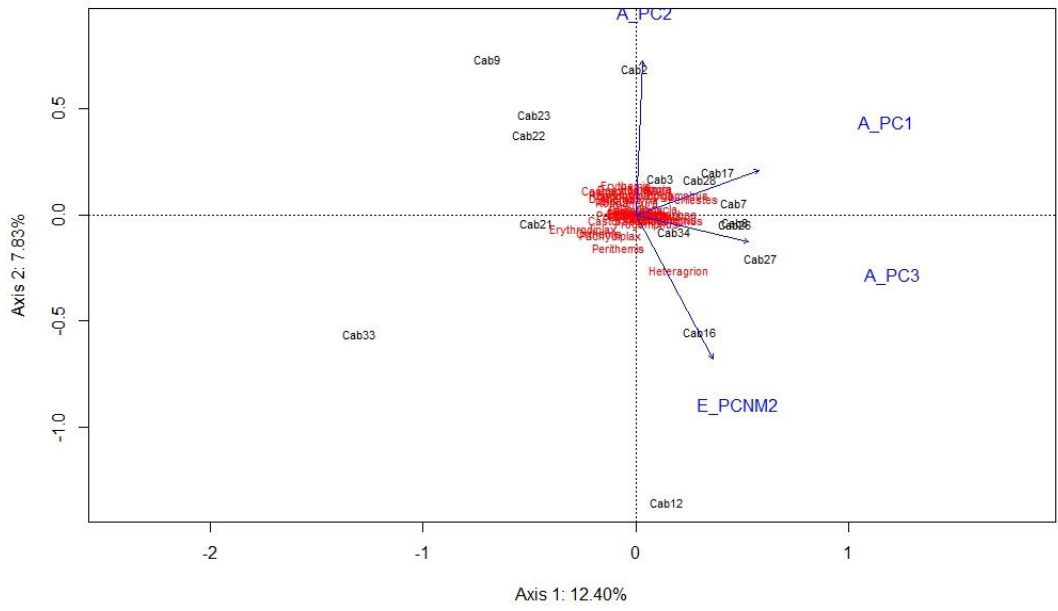
Figure 5. Results of the redundancy analysis showing the relationships among spatial variables, environmental variables, and larvae of Odonata. A_ = Environmental variable axes and E_ = Spatial variable axes. Table 3. Partition of the RDA for environmental and spatial variables related to larvae.